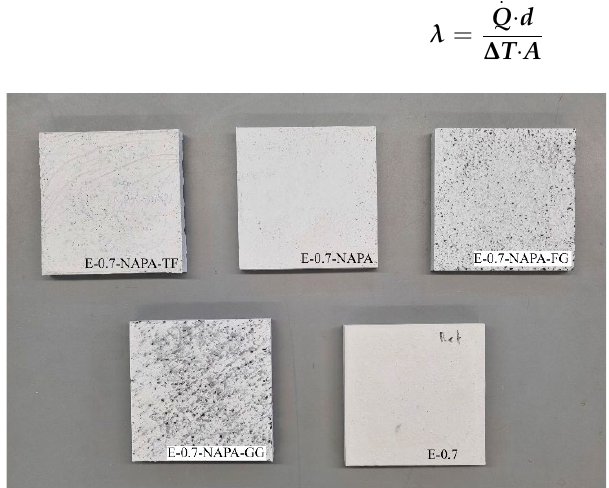
Figure 8. 150 × 150 × 20 mm 3 guarded hot plate samples used.